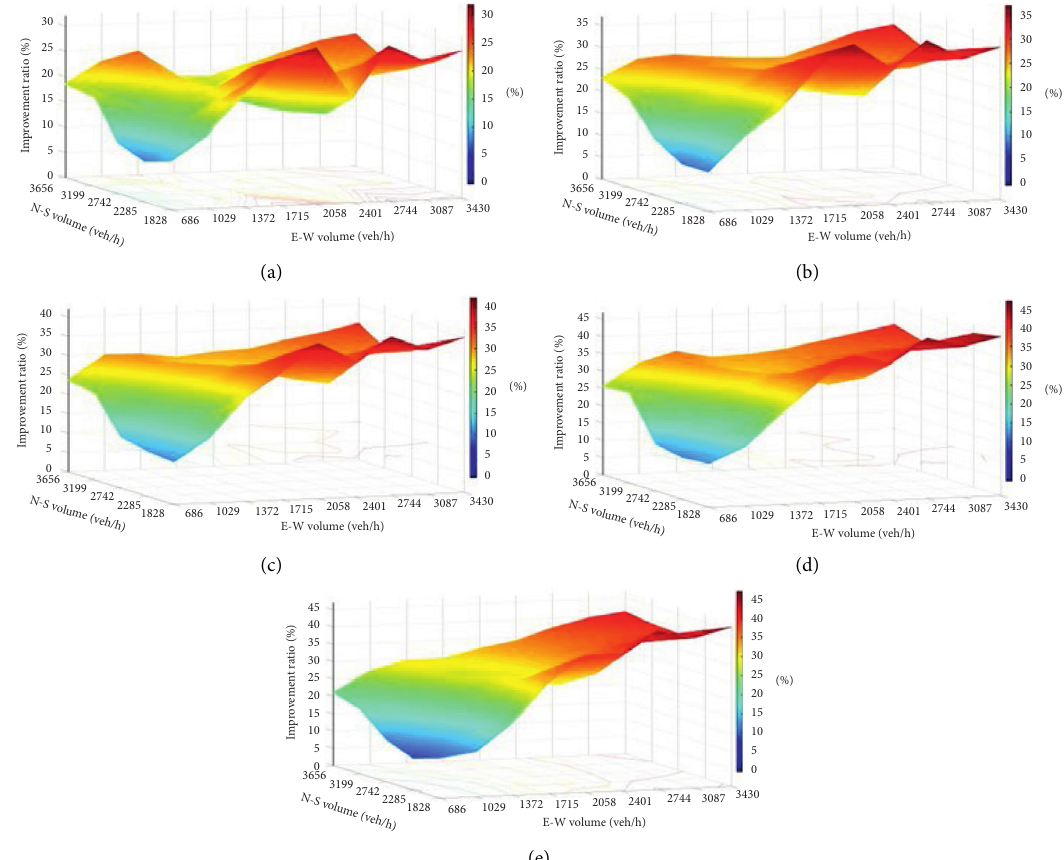
Figure 10: Improvement ratios of delays. (a) Scheme 1. (b) Scheme 2. (c) Scheme 3. (d) Scheme 4. (e) Scheme 5. E-W volume means the same traffic volume of east entrance and west entrance. N-S volume means the same traffic volume of north entrance and south